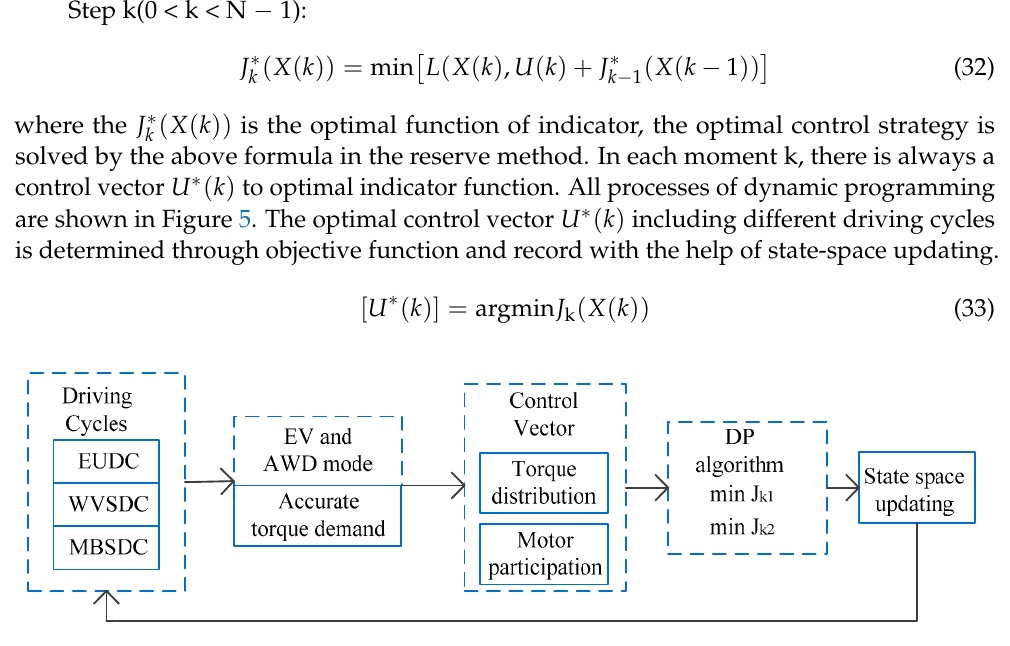
Figure 5. Configuration diagram of dynamic programming algorithm.